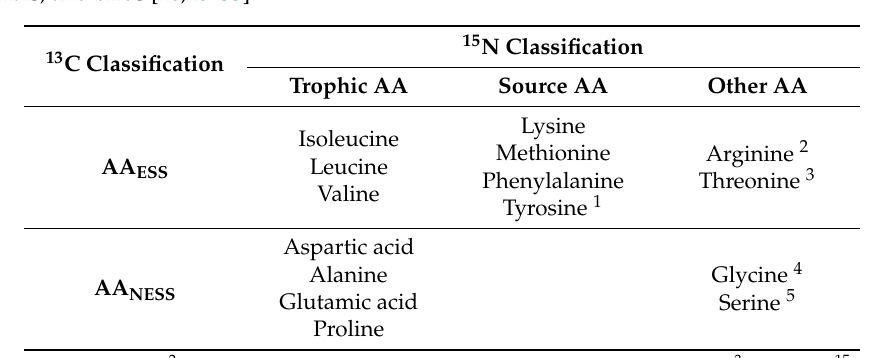
Table 1. Classification of 15 standard amino acids (AA) for which stable isotope carbon ( δ 13 C) or nitrogen ( δ 15 N) values have been measured. Classifications based on data from invertebrates, fish, mammals, and birds